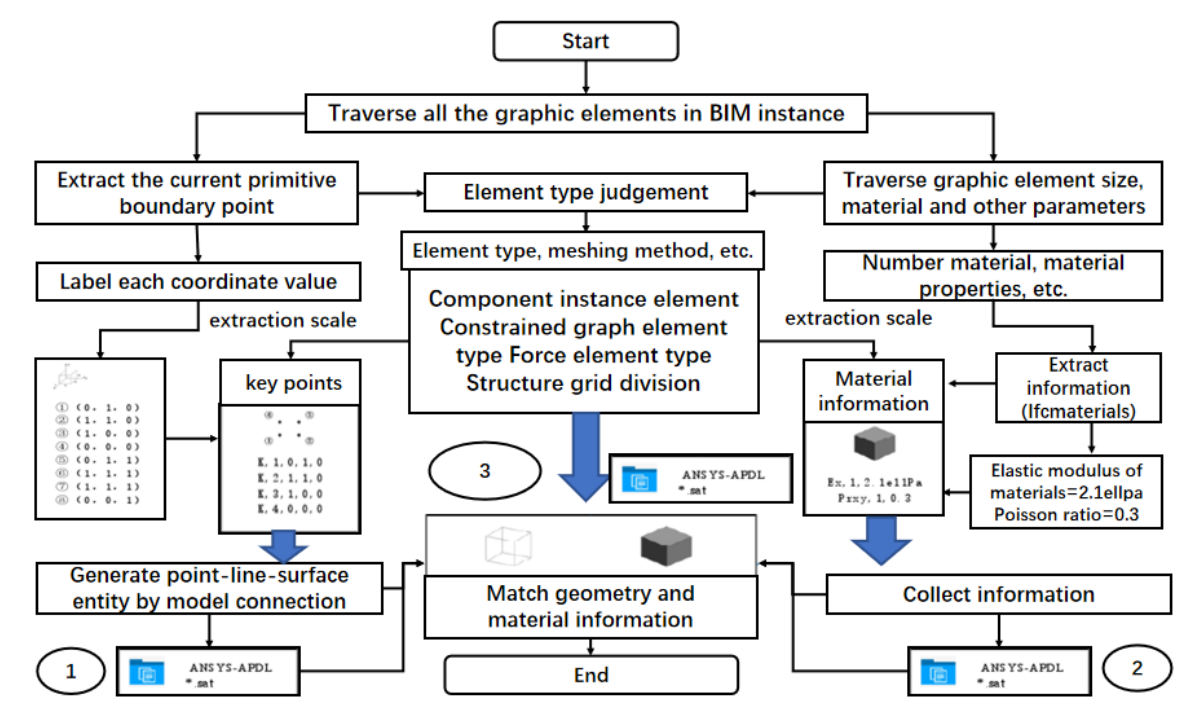
Figure 9. BIM-FEM model transformation process and method.